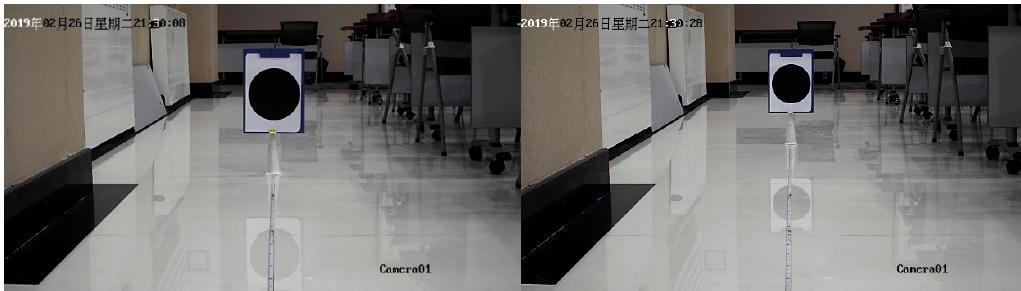
Figure 10. Schematic of the Calibration test.